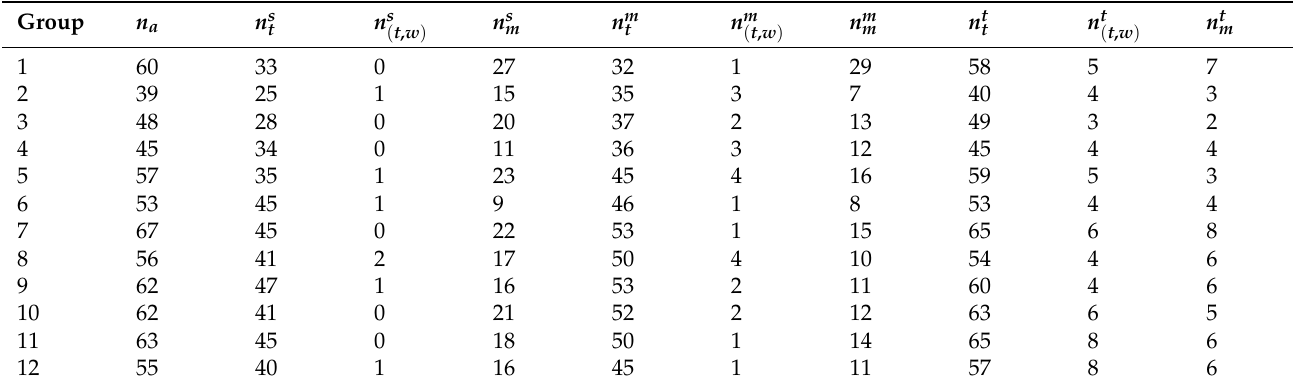
Table 1. Results of three traffic detection algorithms.